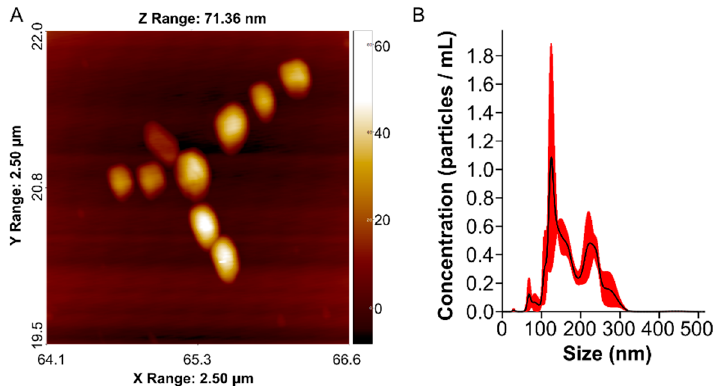
Figure 1. ( A ) AFM analysis and ( B ) NTA size diagram of the TAT–PLGA(DOXO-BMNPs) nanoas-